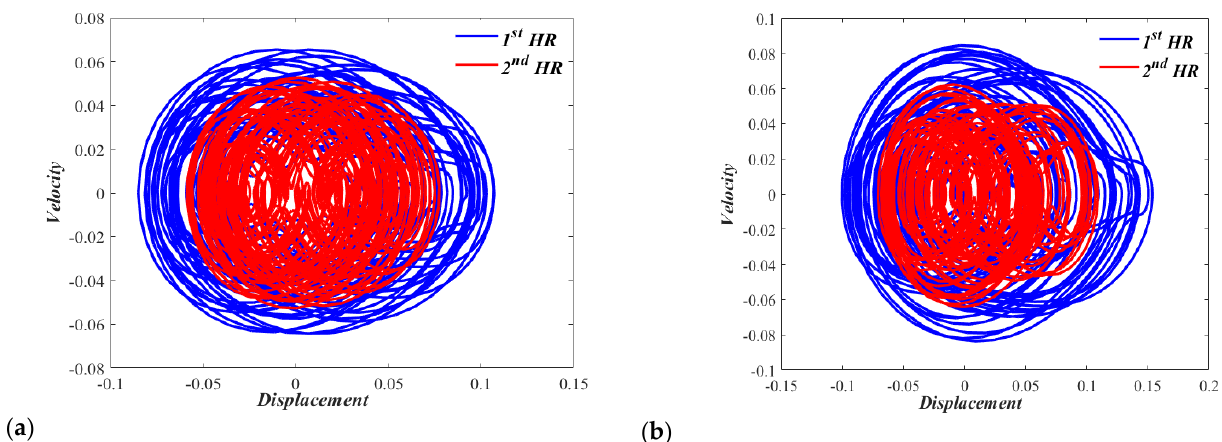
Figure 10. Phase portrait for the nonlinear (CASE I) dual HR excited by, ( a ) p = 165 dB, and ( a ) p = 170 dB.